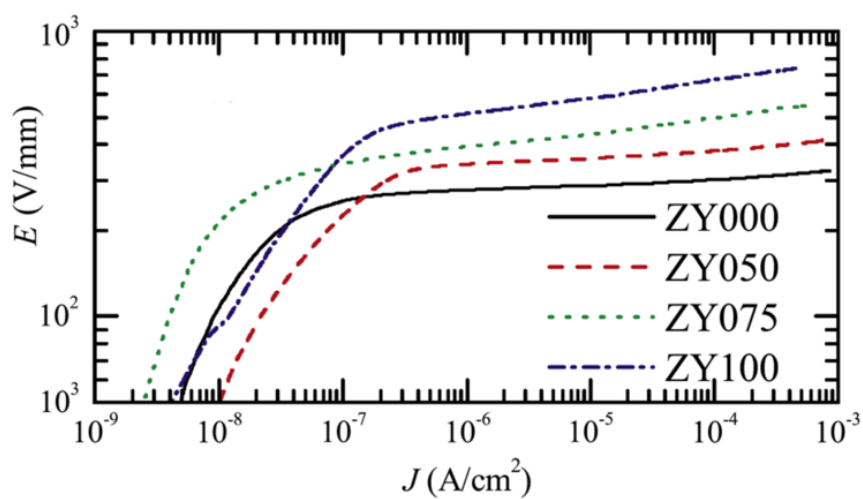
14 of 57 Figure 12. Schematic of conduction paths in nonlinear composites. ( a ) Large diameter particle with small grain size, ( b ) small diameter particle with small grain size, ( c ) large diameter particle with large grain size. © 2021 IEEE. Reprinted, with permission, from [56]. 4.1.3. Effect of Chemical Treatment Because the nonlinear properties of composites depend on the chemical structure of ZnO, it is possible to control E b and 𝛼 by modifying the bulk properties of the ZnO filler. For example, He et al. [79] studied ZnO varistors doped with different Y 2 O 3 concentra- tions. The compositions of ZnO varistors were (95.05- x ) mol % ZnO, 0.70 mol % Bi 2 O 3 , 0.50